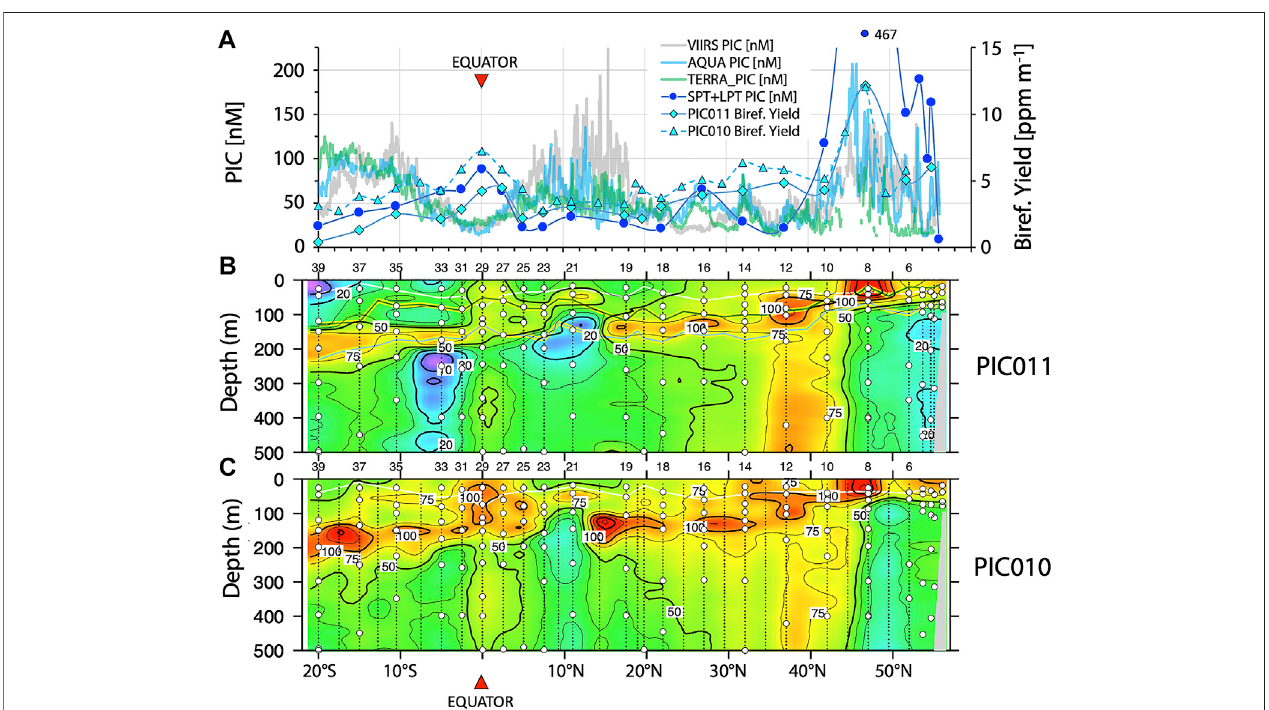
FIGURE 11 | (A) Comparison of MODIS AQUA, TERRA, and VIRRS SNPP satellite retrievals of surface layer PIC concentrations, PIC from shallow McLane samples, and birefringent photon yield from sensors PIC010 and PIC011. (B) Transect section to 500 m of PIC calculated from PIC011 at McLane pump stations. The white line denotes mixed layer depth, the broad yellow/green curve denote the depth of maximum chlorophyll fl uorescence. The lower broad curve denotes the base of the euphotic zone. Stations numbers are at the top axis of the section. (C) Transect section to 500 m from PIC010 deployed during GTC CTD casts. GTC casts were done at almost all of the 39 stations along the transect and thus the section has fi ner spatial resolution than (B) . Both PIC010 and PIC011 display PIC minimum values in the low O2 zone at station 21.